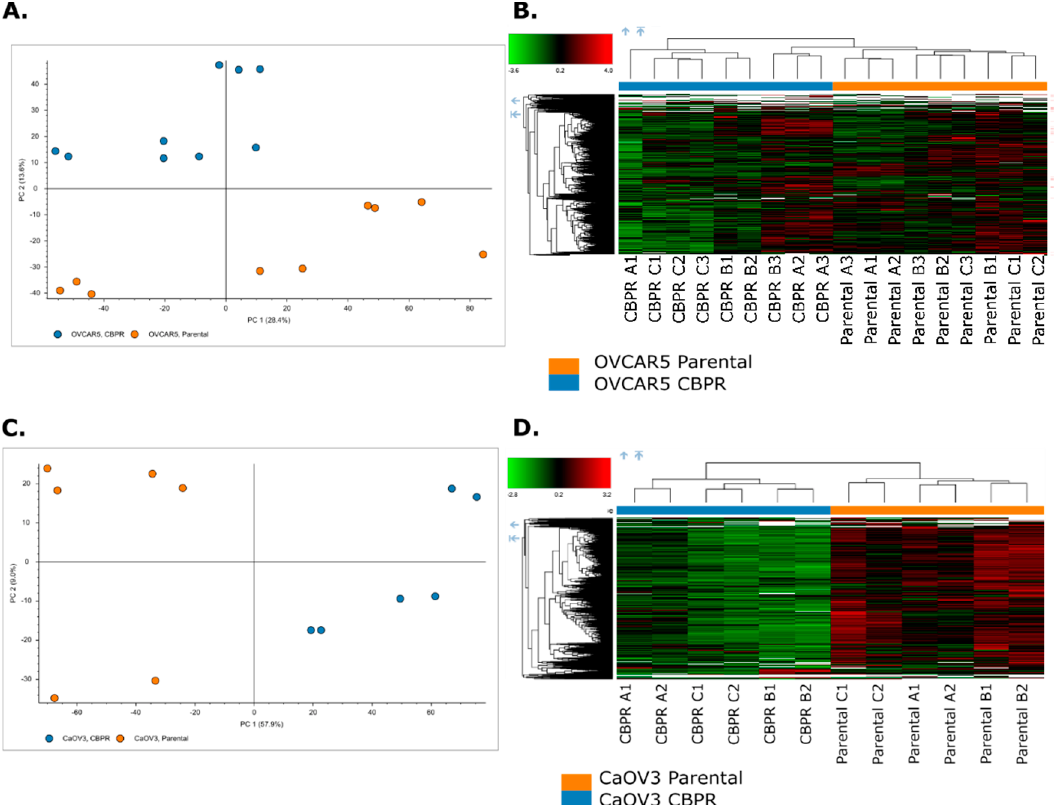
Figure 5. Principle component analysis (PCA) and hierarchical clustering of proteomic features of parental (orange) and the CBPR (blue) cancer cell lines ( A , B ) OVCAR-5, ( C , D ) CaOV3. Analysis was performed with Proteome Discoverer (Thermo) inbuilt data visualisation tools.